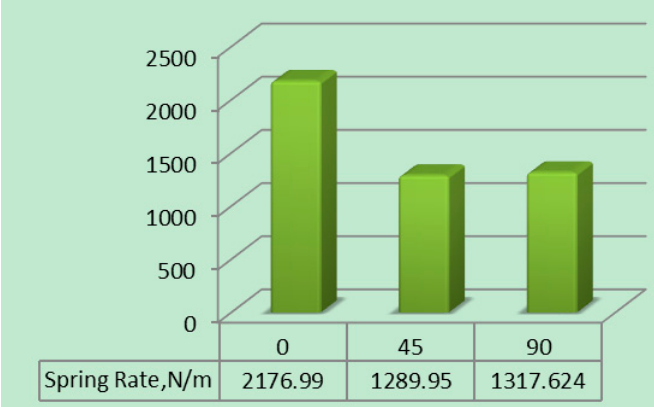
Figure 14. Spring rate of leaf spring for different fiber orientations.